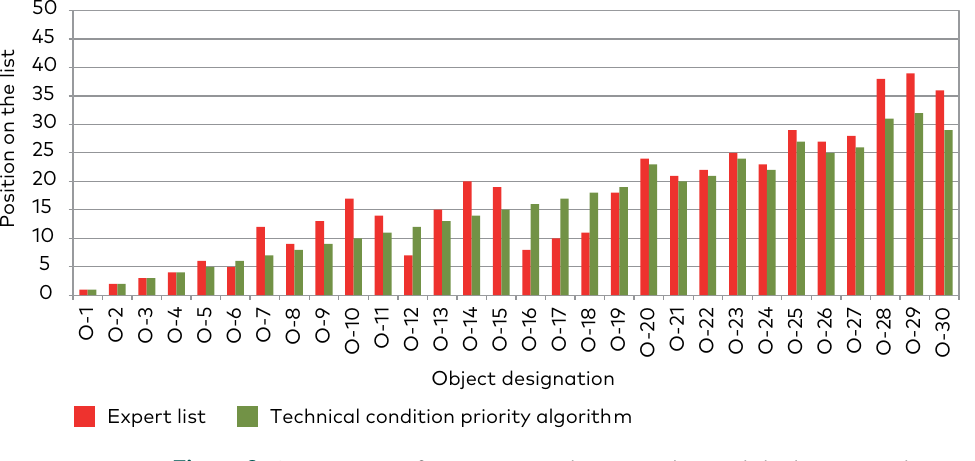
Figure 2. Comparison of a position in the expert list and the list created by the technical condition priority